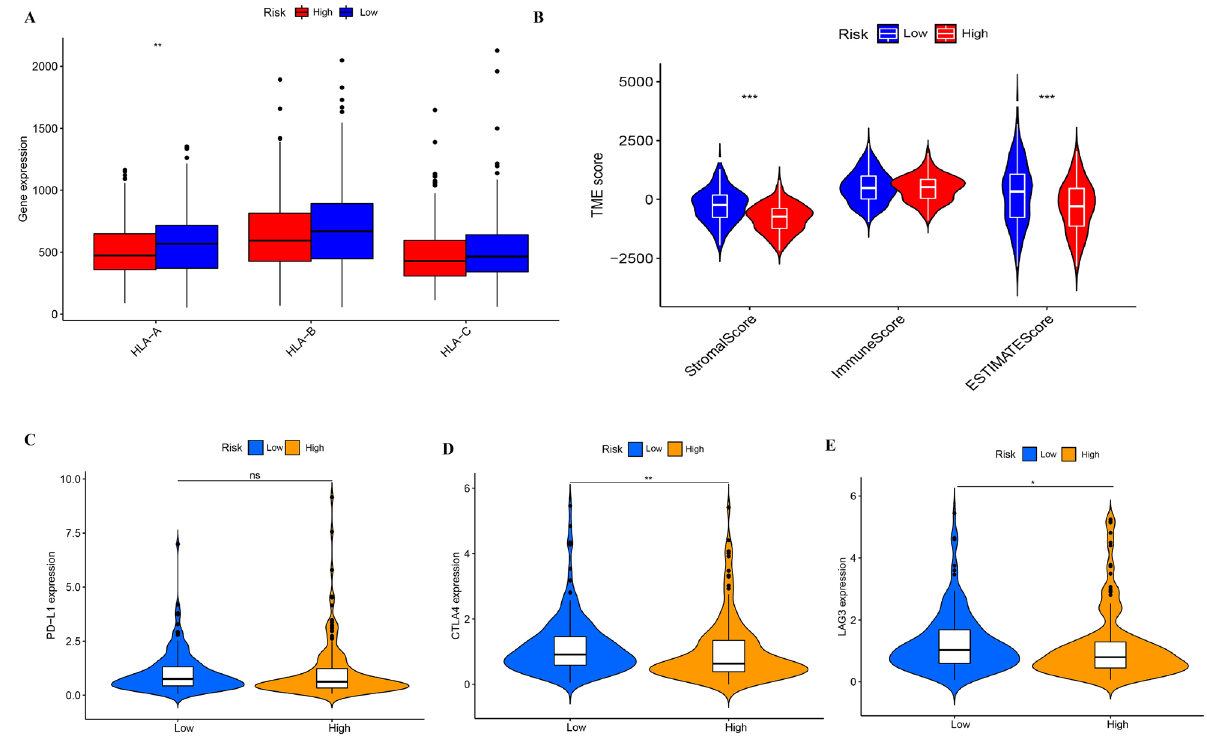
Figure 10. Immune-related analysis between groups. ( A ) The expression difference of HLA family between groups. ( B ) Immune score to estimate tumor purity for groups. ( C )–( E ) The expression of typical immune checkpoints.